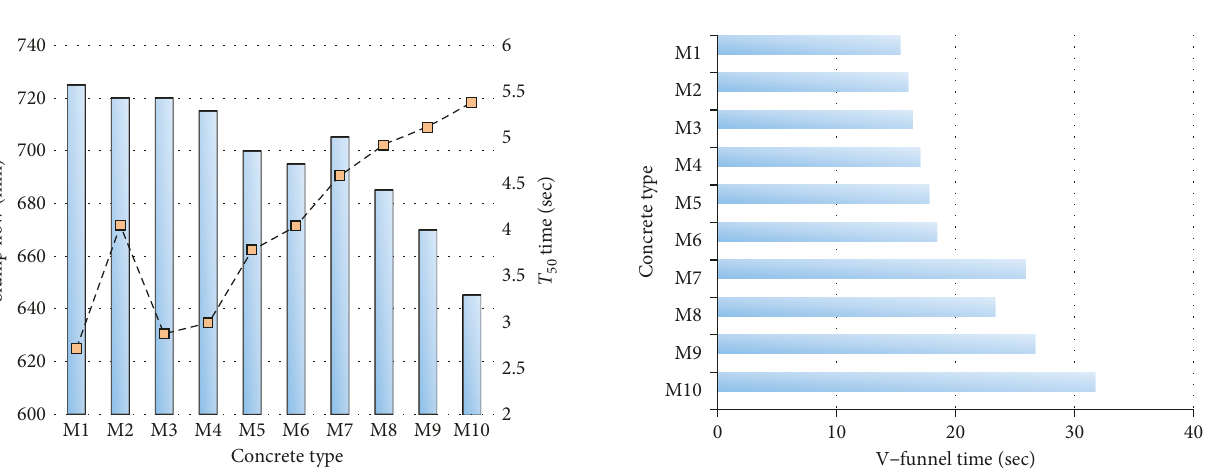
Figure 5: V-funnel time of the SCC series. Figure 4: Slump flow and T 50 time of the SCC series.